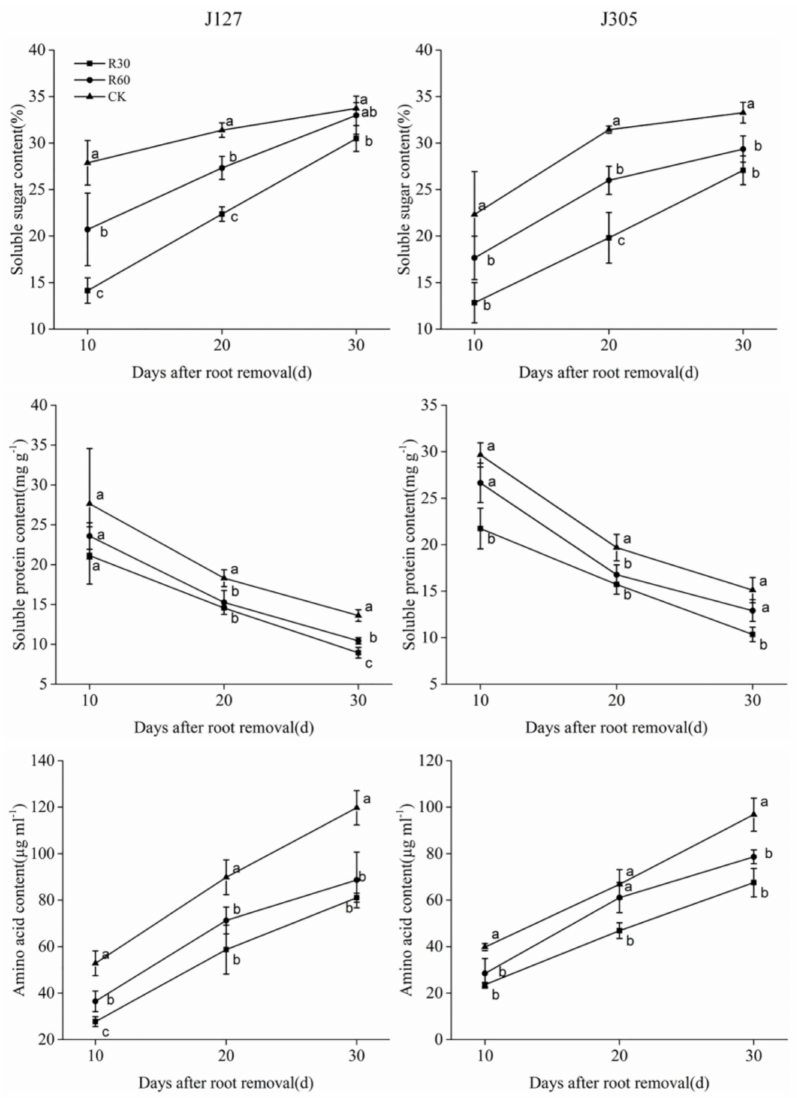
Figure 4. E ff ects of root removal in di ff erent soil depths on soluble sugar content, soluble protein content, and amino acid content in root bleeding sap. No roots removed, CK; roots removed at 30 cm underground, R30; roots removed at 60 cm underground, R60. Di ff erent characters at the same stage indicate significant di ff erences at p < 0.05. Vertical bars represent the standard deviation of three replications ( n =